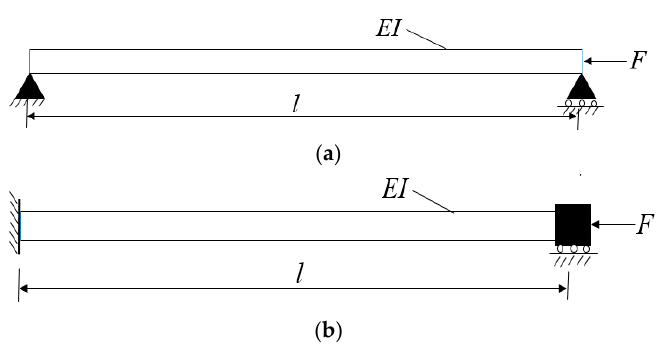
Figure 2. Transversely vibrating quintic nonlinear beam ( a ) simply supported (S-S) and ( b ) clamped-clamped (C-C).